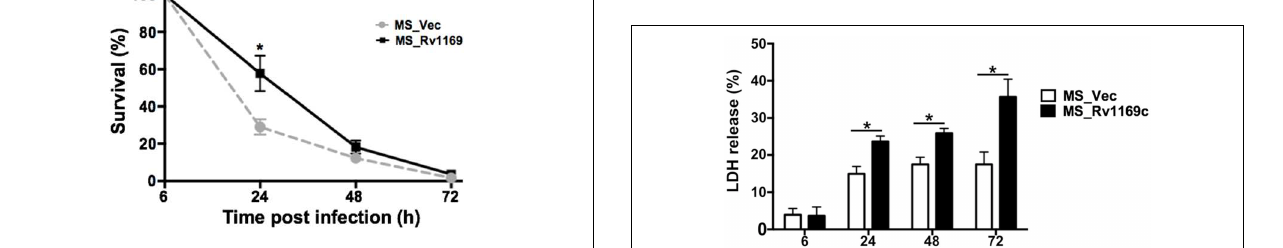
FIGURE 7 | Assay of cell death in macrophages infected with Ms_Vec or Ms_Rv1169c. Macrophages were infected with Ms_Vec (white bars) or Ms_Rv1169c (black bars) at an MOI of 10. After 6, 24, 48, and 72h infection, culture supernatants were collected and the release of LDH was measured. Data are shown as means ± SEM of triplicate wells. * P < 0 . 05